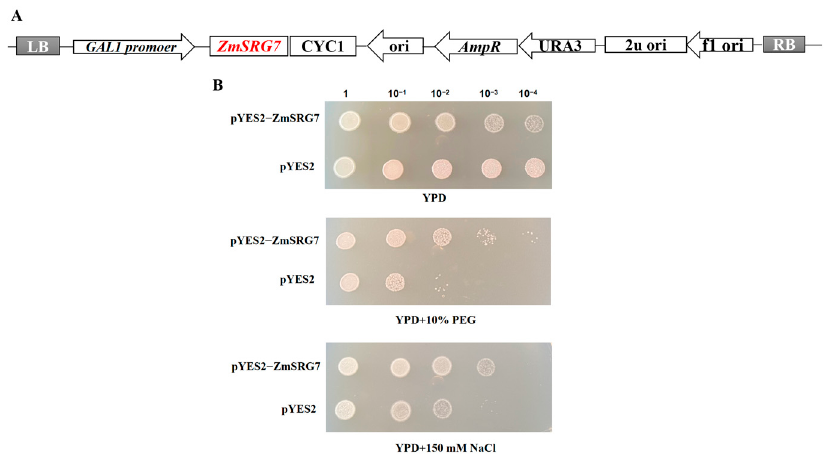
Figure 7. Growth of ZmSRG7 in yeast. ( A ) construction of yeast overexpression vector of pYES2:ZmSRG7. ( B ) growth of yeast under 10% PEG6000, 150 mM NaCl stress. pYES2:ZmSRG7. ( B ) growth of yeast under 10% PEG6000, 150 mM NaCl